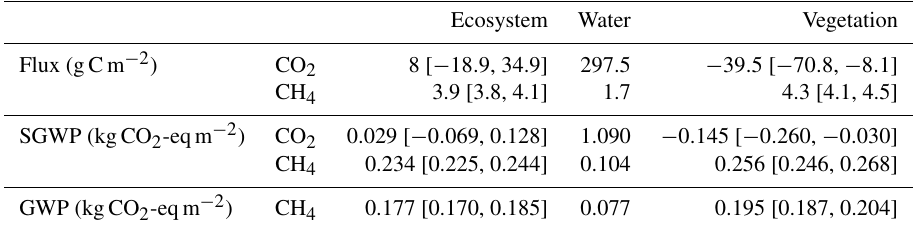
Figure 7. Wavelet coherence analysis and the phase difference between ecosystem fluxes, the net ecosystem exchange (NEE) and the CH 4 flux ( F CH ), and nutrient concentration in the water, NO 3 -N and total phosphorus from January to December 2013. The colour represents 4 the power of the coherence from 0 to 1. The phase difference is indicated by black arrows which only show up where the coherence is greater than or equal to 0.5. Rightwards arrow ( → ) indicates in-phase (two time series in synchrony) and arrows in other direction indicate out of phase (representing lags between time series); i.e. leftwards arrow ( ← ) indicates anti-phase, downwards arrow ( ↓ ) indicates the first series (fluxes) leads by quarter cycle and upwards arrow ( ↑ ) indicates the second series (NO 3 -N and total phosphorus) leads by quarter cycle. White dash contour lines indicate the cone of influence. Table 2. Annual CO 2 and CH 4 exchange, their sustained global warming potential (SGWP) and global warming potential (GWP) from different surface zones in the Nummela wetland in 2013. “Ecosystem”, “water” and “vegetation” represent flux, SGWP and GWP measured or calculated from the ecosystem by the EC tower, from the open-water and vegetated areas, respectively. The numbers in the square bracket represent the 95% confidence interval of the average. No error bounds are reported for flux, SGWP and GWP from open water as they are modelled using gas concentration in the water and meteorological